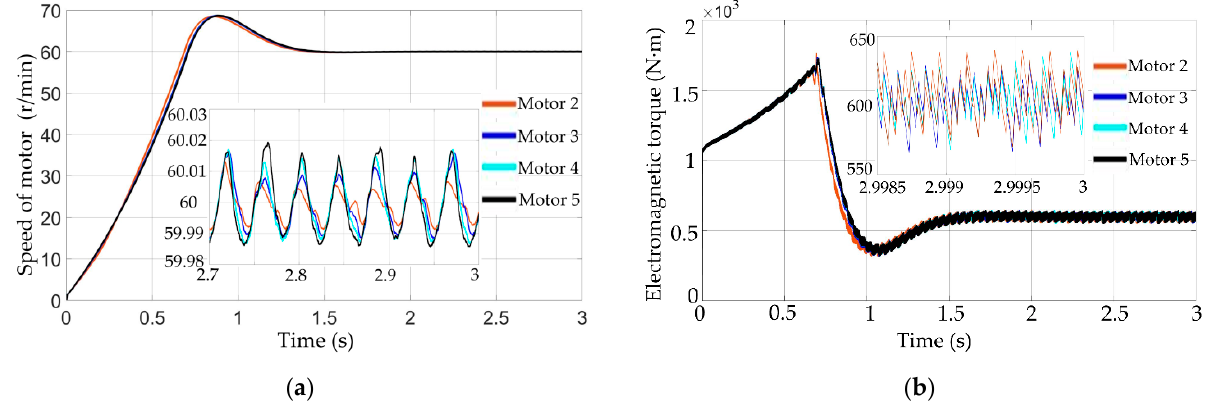
Figure 12. The response curve of the roller motor of the distributed permanent magnet direct-drive belt conveyor system under light load operating conditions. ( a ) Speed curve; ( b ) Electromagnetic torque curve.